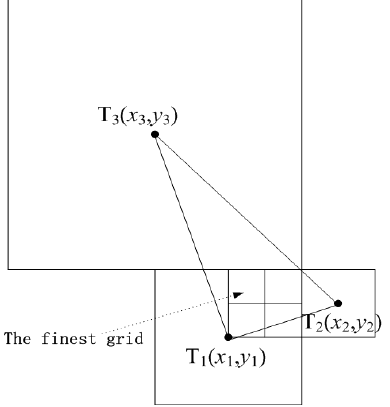
Figure 6. Linear interpolation in northeast block of grid 1.